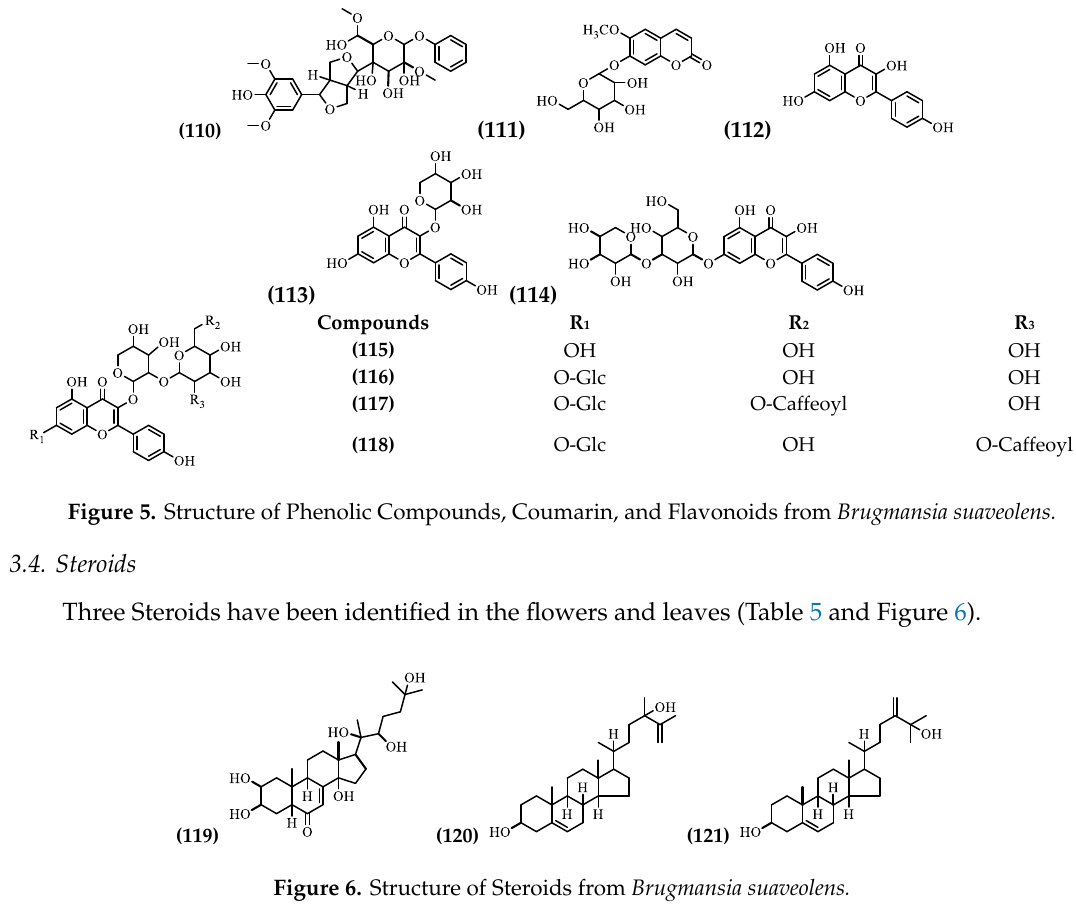
Table 6. Hydrocarbons from Brugmansia suaveolens.